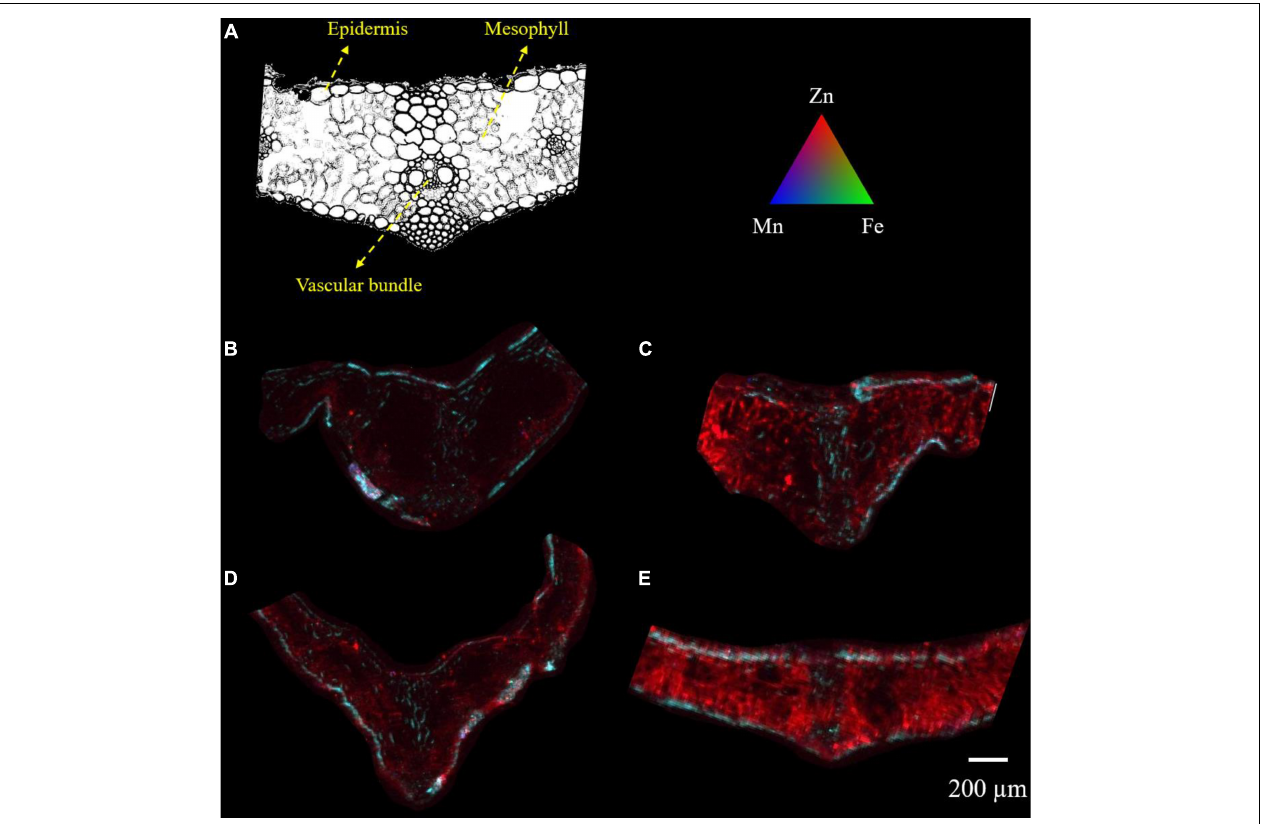
FIGURE 3 | Microscope cross section (A) and µ -XRF elemental maps (B–E) for Zn (red), Fe (green), and Mn (blue) of wheat leaf treated with different foliar fertilizers: − Zn-CK (B) , +Zn-CK (C) , − Zn+Ino (D) , and +Zn+Ino (E) . Pixel brightness for µ -XRF map (B–E) is displayed in RGB, with the brightest spots corresponding to the highest elemental fluorescence. Scale bar: 200 µ m. n = 4, representative images shown.